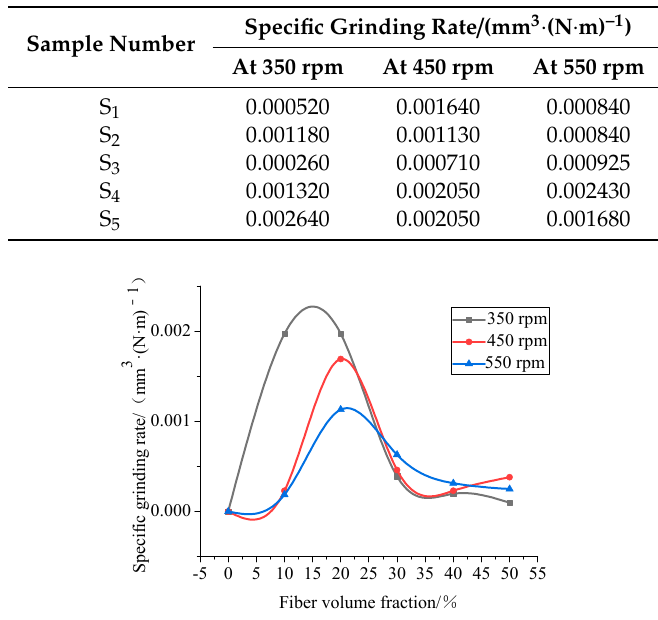
Table 5. Specific wear rates of palm-kernel particles of type 2 composites at different velocities and volume fractions.